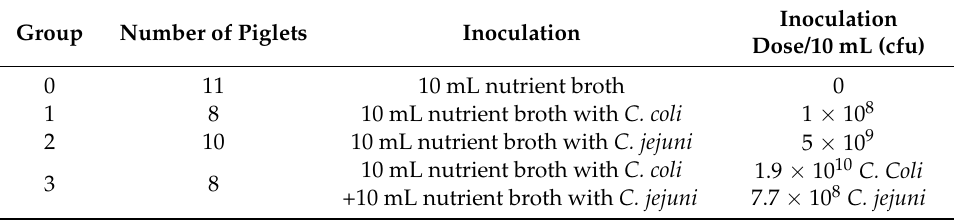
Table 1. Infection scheme of the animal groups. Group Number of Piglets Inoculation